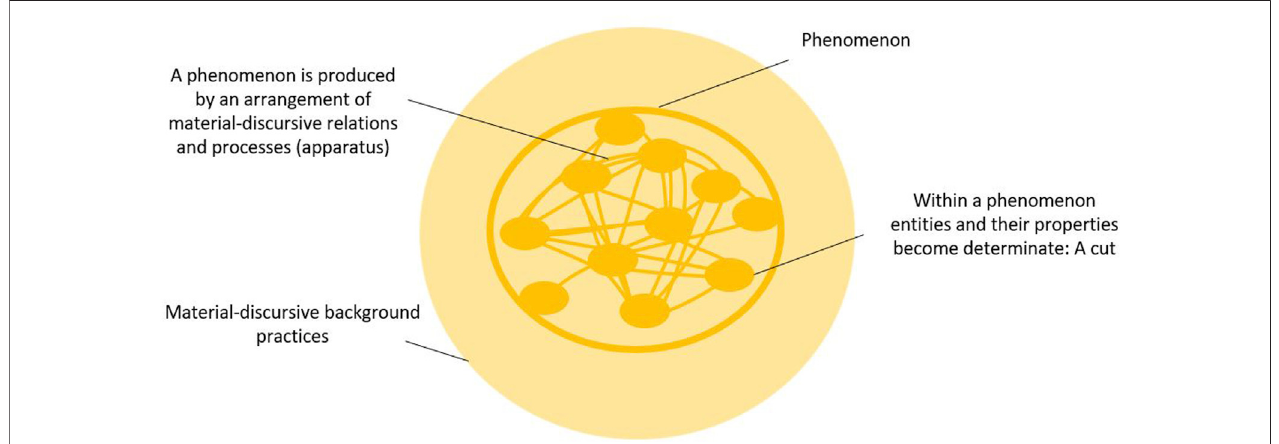
FIGURE 1 | Cuts, phenomena and apparatuses - adapted from Schlüter et al.